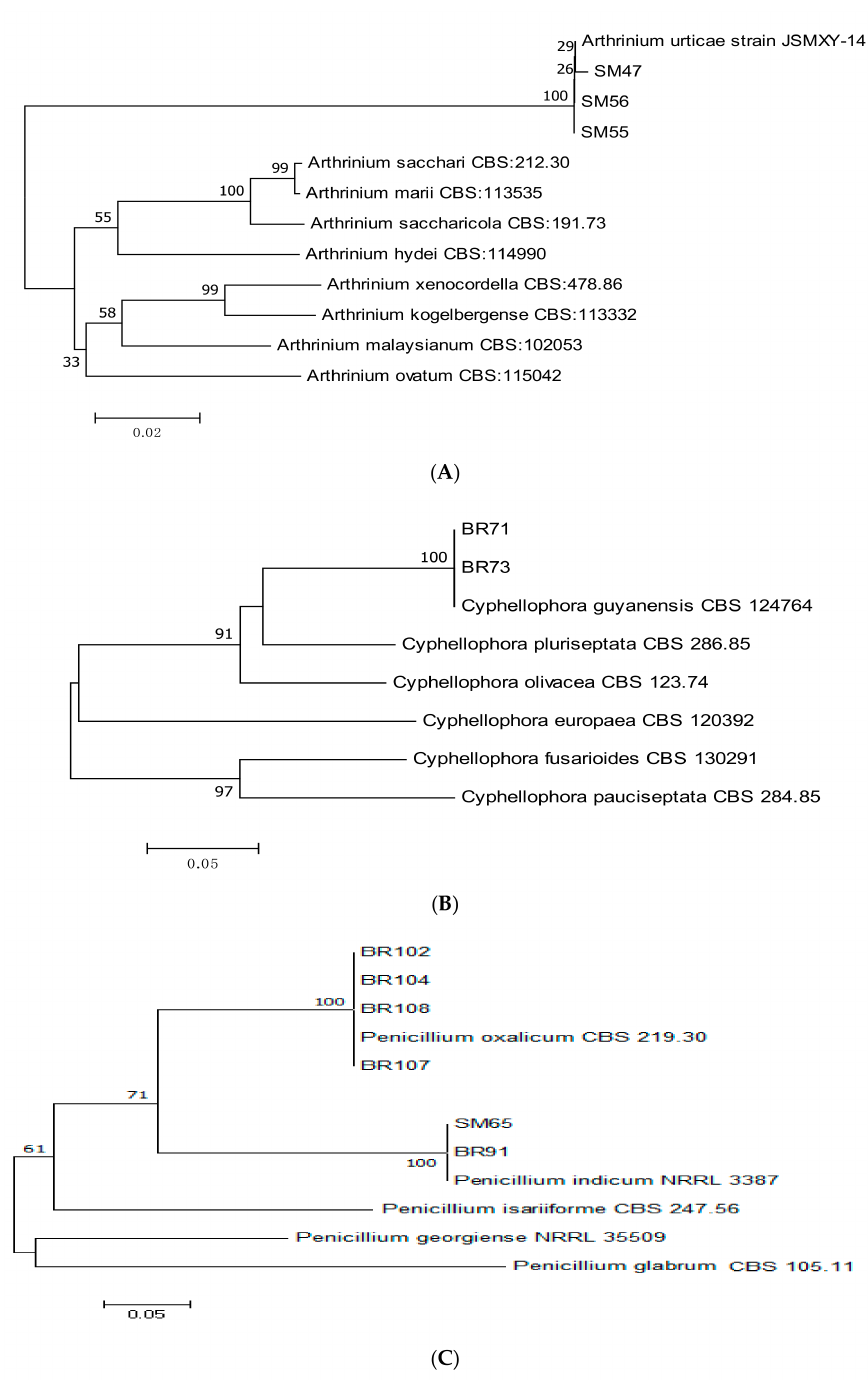
Figure 7. Maximum likelihood tree inferred from combined sequences of ITS and β -tubulin for ( A ) Arthrinium urticae, ( B ) Cyphellophora guyanensis , and ( C ) Penicillium spp. from C. castaneus spines with bootstrap values higher than 50% are shown next to the branches. Four species of endophytic Fusarium , F. lateritium ( n = 2), F. decemcellulare ( n = 2), F. oxysporum ( n = 1), and F. solani ( n = 1) were identified using TEF-1 α and β